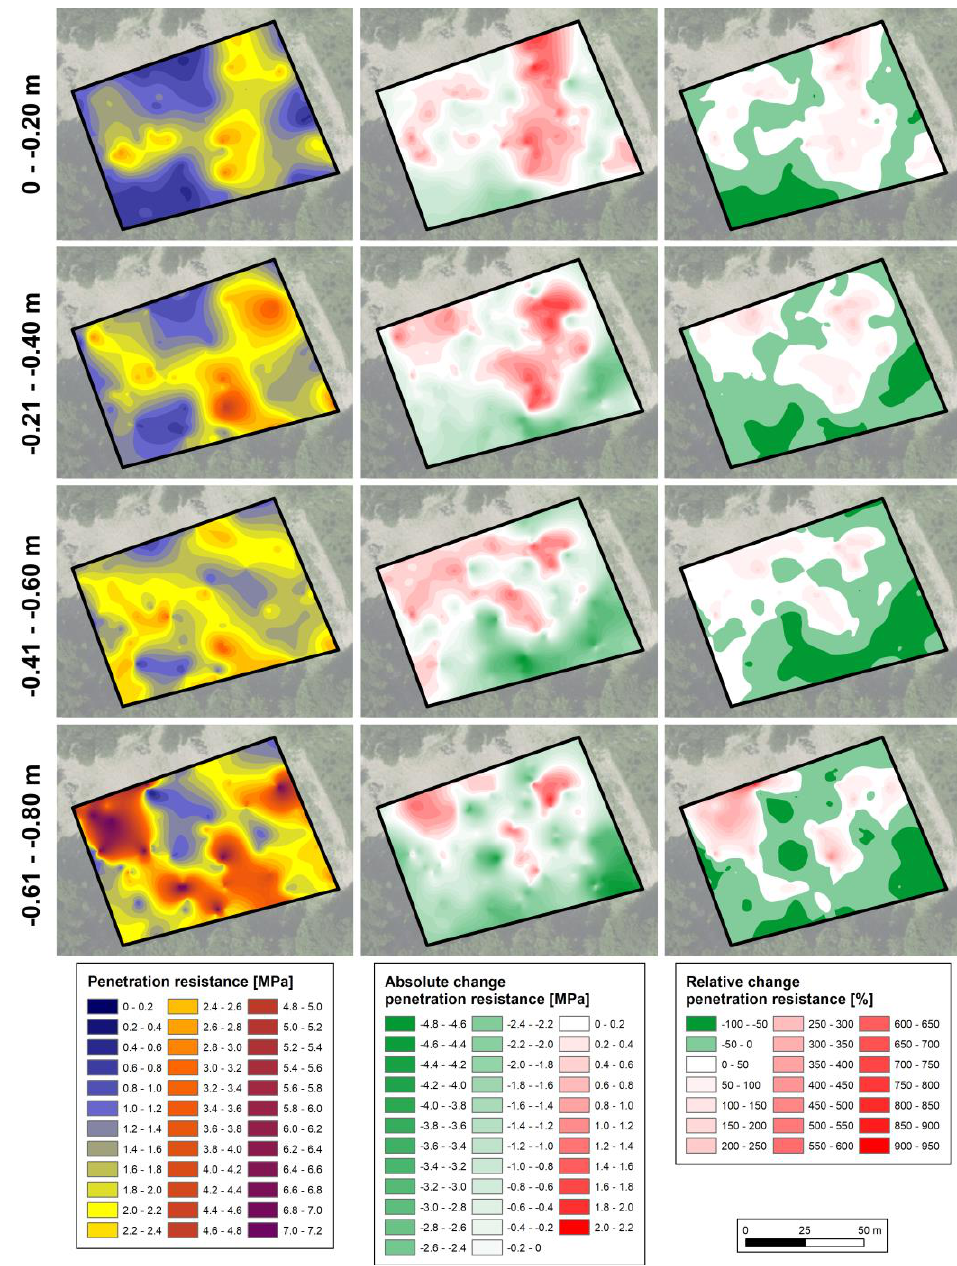
Figure 15. Interpolated penetration resistance, absolute and relative change of penetration resistance, CUT EX compared to CUT. Aerial photography provided by LVermGeo RLP (2019).